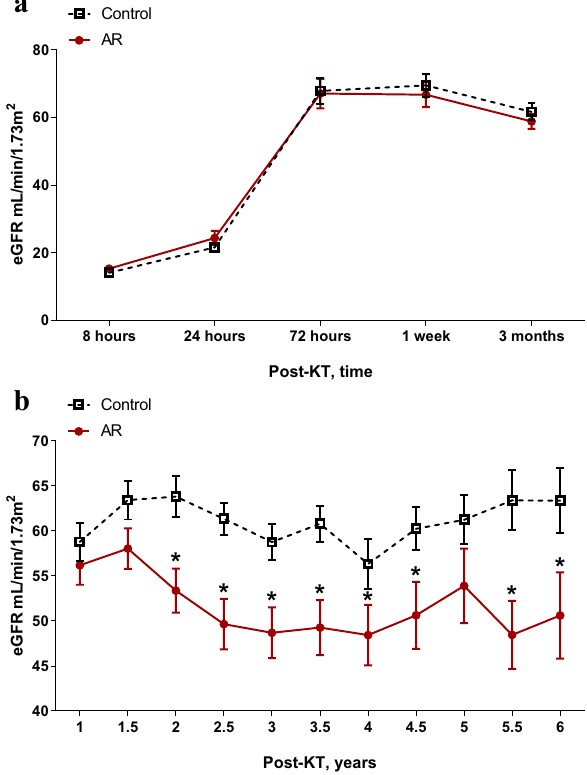
Figure 1. Serial changes in renal function. The eGFR from 2 years after KT was significantly lower in the AR group compared with the control group. * P < 0.05 compared with the control group. AR acute rejection, eGFR estimated glomerular filtration rate, KT kidney transplantation. Data are shown as mean ± standard error of